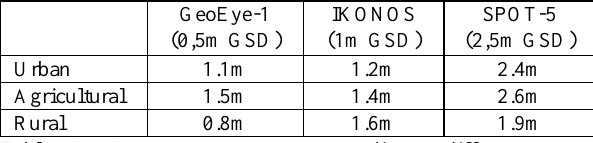
Table 3. Root mean square coordinate differences at independent check points - tie points determined by matching - scene orientation by bias corrected RPC